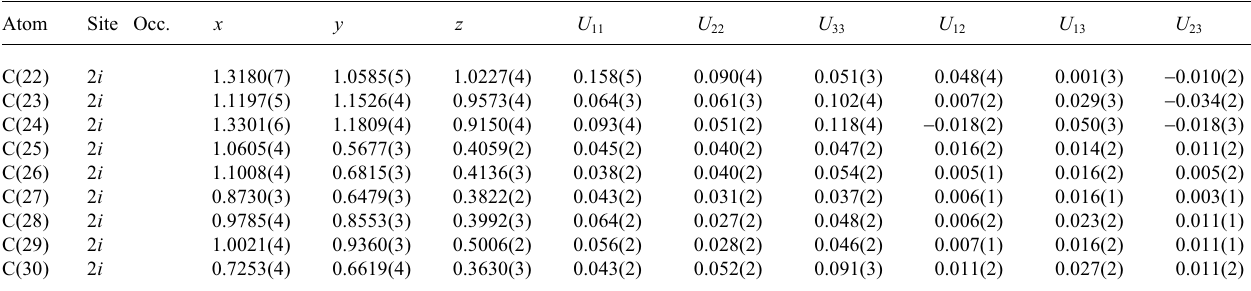
Table 3. Atomic coordinates and displacement parameters (in Å 2 ) . Atom Site